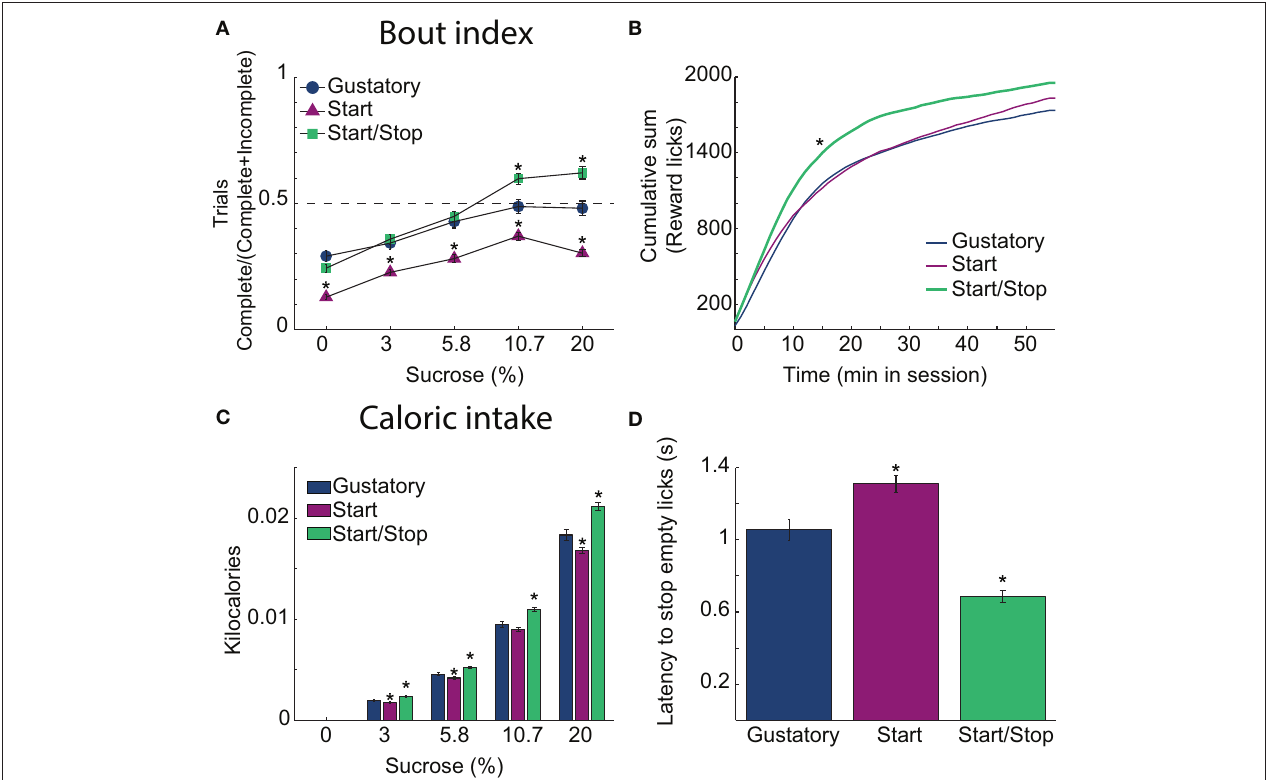
FIGURE 3 | Auditory Start/Stop cues increase the Bout index, number of rewards obtained and caloric intake. (A) The Bout indices (the ratio of the number of Complete trials to the number of Complete and Incomplete trials) for the three brief-access tests plotted as a function of sucrose concentration. The order was: Start/Stop (green) > Gustatory (blue) > Start (purple). Values are mean ± sem across trials. (B) The cumulative sum of rewarded (wet) licks in the Reward epoch over the 55min session for each test. The Start/Stop test had the largest number of rewarded licks. (C) A histogram is displaying the average caloric intake as a function of sucrose concentration for the three brief-access tests. Animals tested in the Start/Stop task consumed significantly more kilocalories (sucrose) than those in the other two brief-access tests. N = 91 sessions for the Gustatory task; 109 for the Start task; 97 for the Start/Stop task. (D) The latency to stop licking the empty sipper